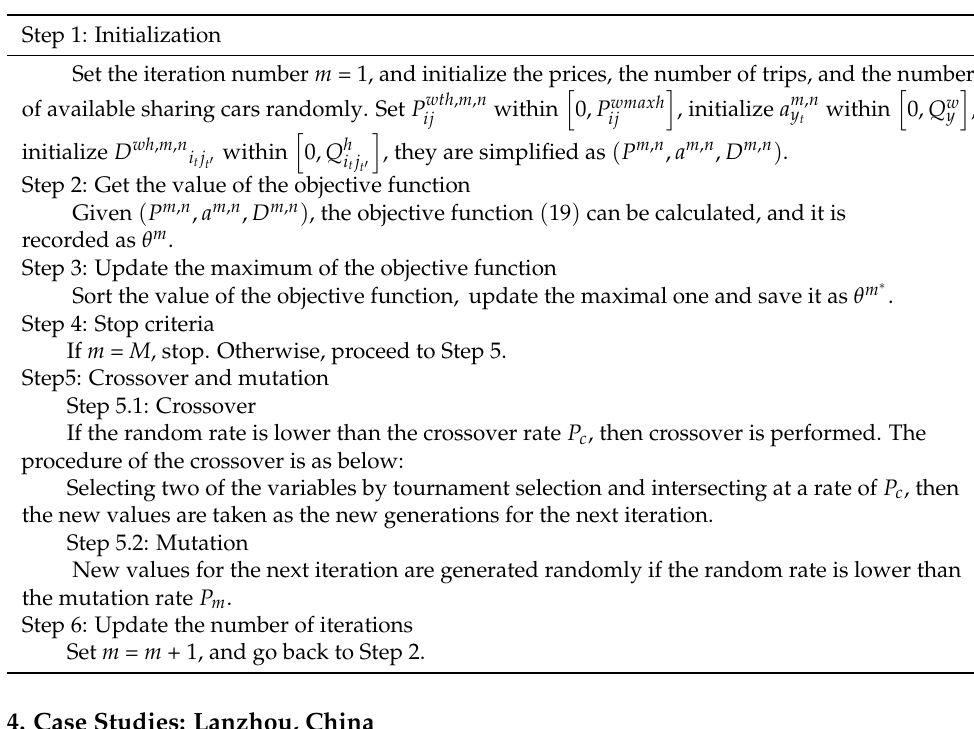
Table 4. Pseudocode of the